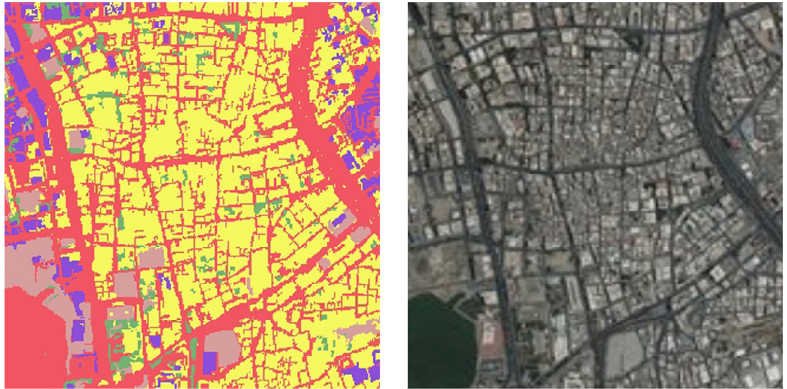
Figure 10. The performance of object-based ML and TSA mapping in an informal settlement. The results were not limited to the informal boundary because they depend on many indicators, such as texture measurements, size, and density.